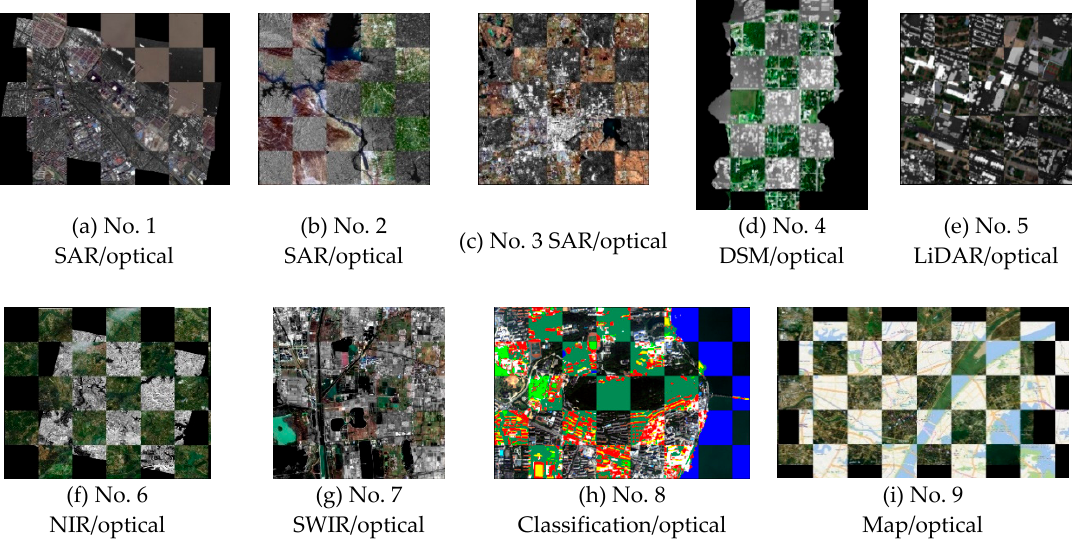
Figure 10. Multimodal remote sensing image registration display.